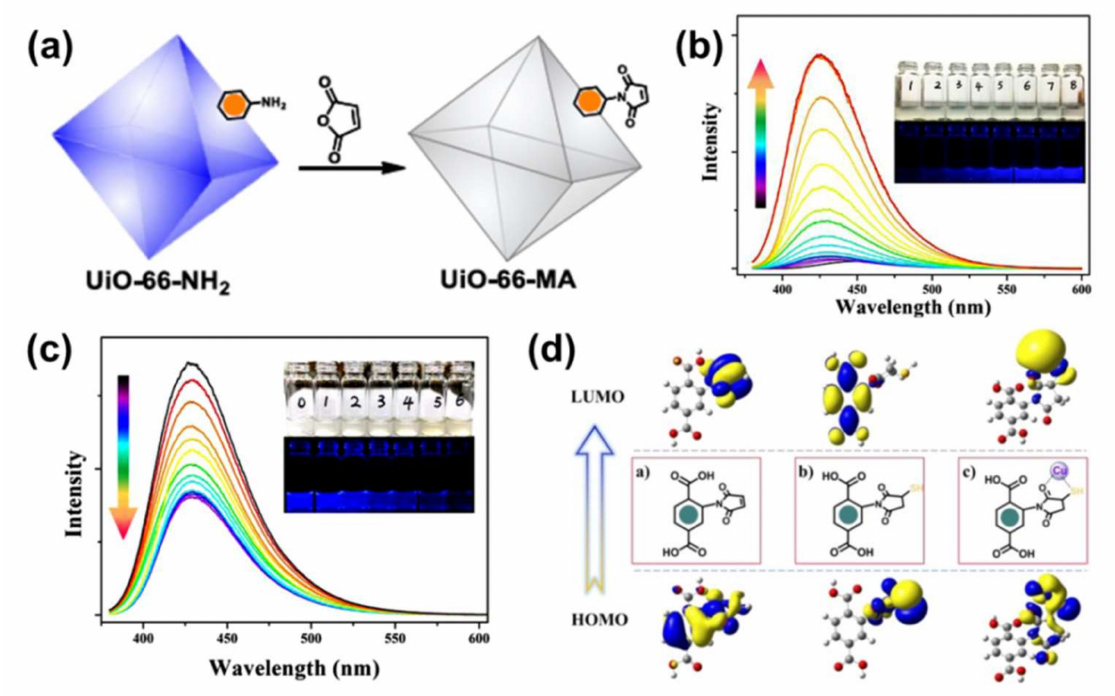
Figure 5. ( a ) The post-synthesis process of UiO-66-MA. ( b ) Fluorescence titration of UiO-66-MA with H 2 S (0-0.625 µ M); inset: images of UiO-66-MA under day light (up) and UV light (down, 365 nm) in the presence of 0, 0.04, 0.08, 0.125, 0.165, 0.25, 0.35, and 0.625 µ M of H 2 S for 1–8, respectively. ( c ) Fluorescence titration of UiO-66-MA/H 2 S with growing concentration of Cu 2+ ; inset: images of UiO-66-MA/H 2 S under day light (up) and UV light (365 nm, down) in the presence of 0, 0.02, 0.07, 0.12, 0.17, 0.22, and 0.35 µ M of Cu 2+ for 0–6, respectively. ( d ) A possible tandem process in view of the Michael addition, and S-Cu integration was calculated by DFT. Adapted from